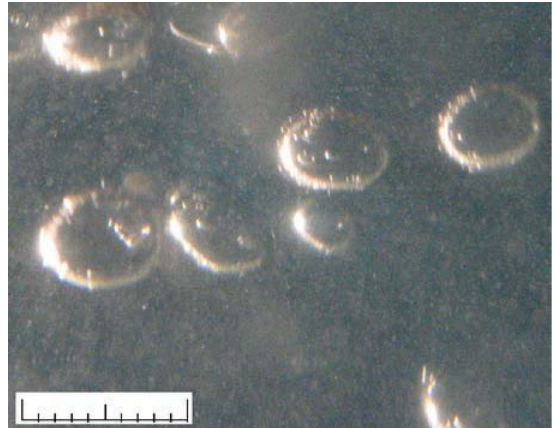
Figure 1. Formation of bubble bunch in the system containing air and butanol solution in water within a bubble column. Tiny bubbles attached to larger bubbles in the middle of picture are obvious. Scale shown on the bottom left is 10